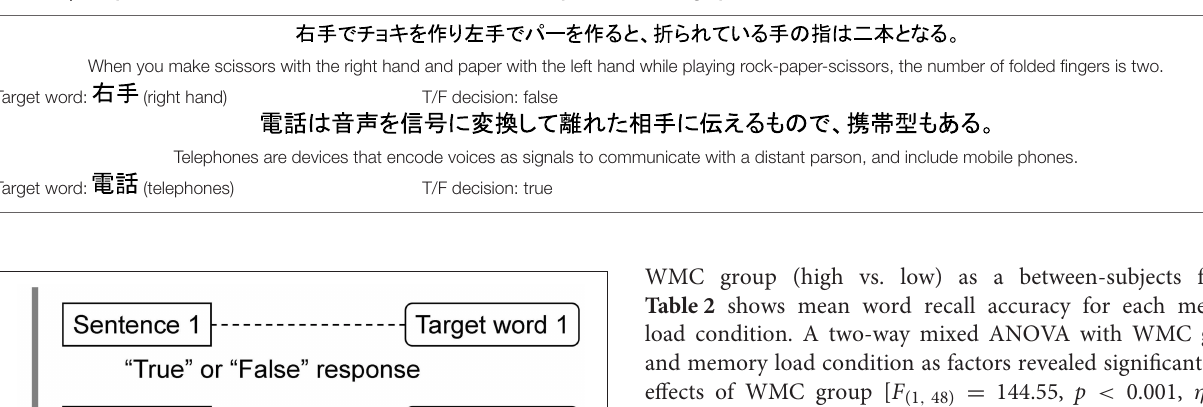
TABLE 1 | Sample sentences in the two-sentence condition of the Japanese Listening Span Test.